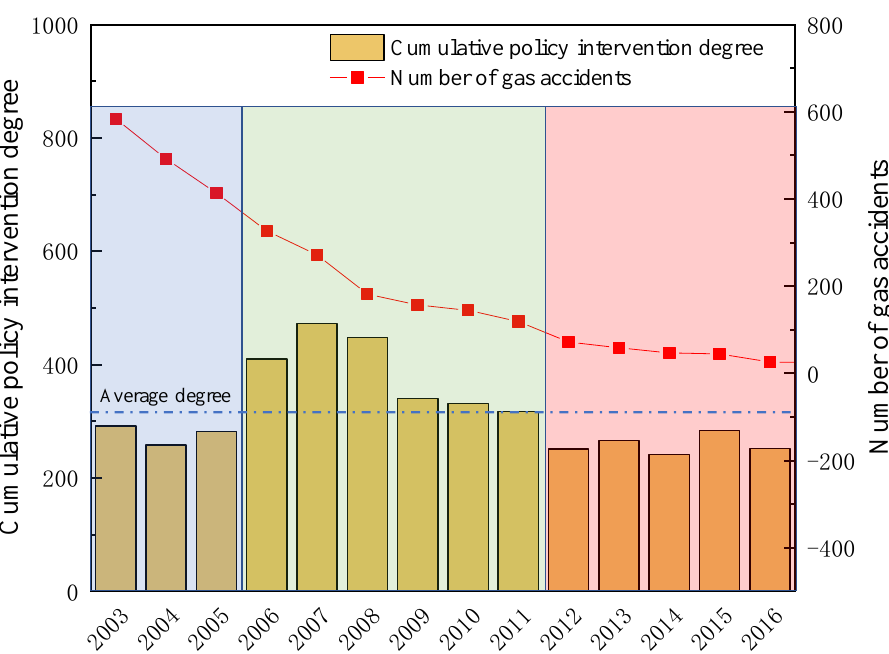
Figure 19. Trend comparison of gas accidents and the policy intervention degree from 2003 to 2016.